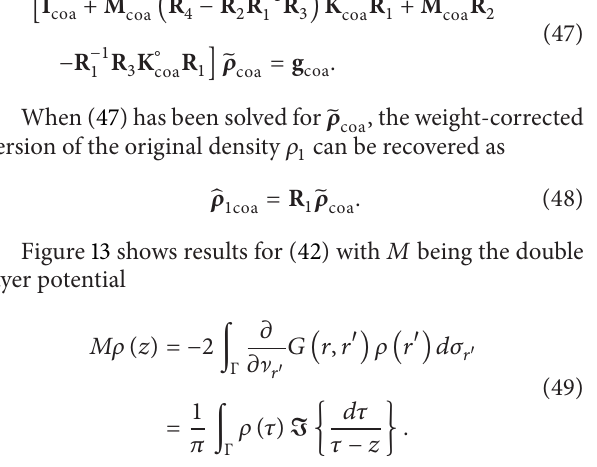
for. This section shows how to apply RCIP to (42) using a simplified version of the scheme in